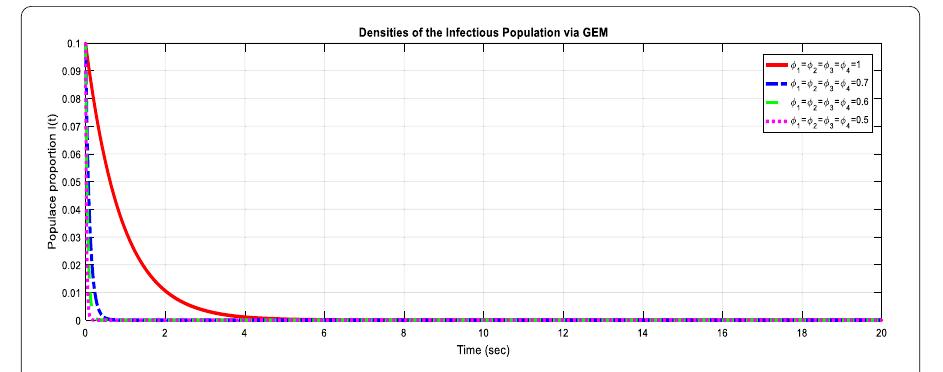
Figure 3 Dynamic of I by varying the value of φ